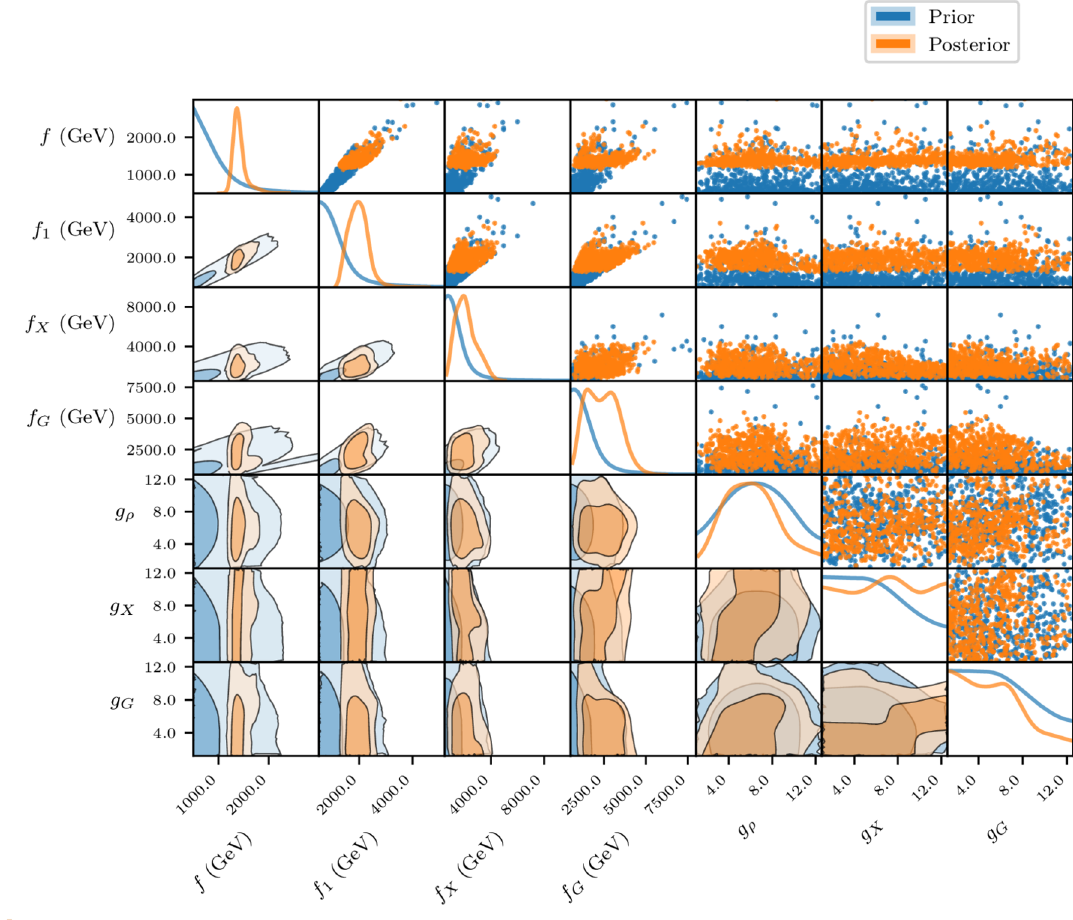
Figure 3. 1D and 2D marginalised priors and posteriors for the gauge sector parameters in the M4DCHM 5 − 5 − 5